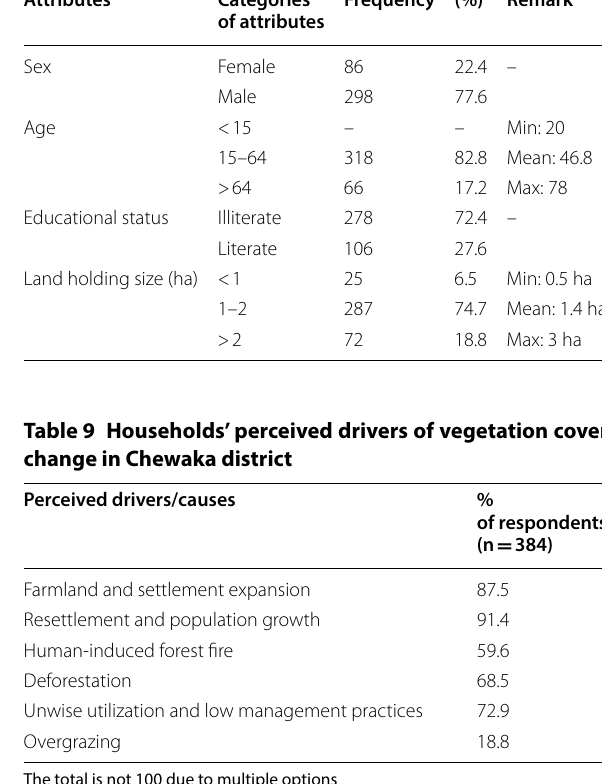
The total is not 100 due to multiple options